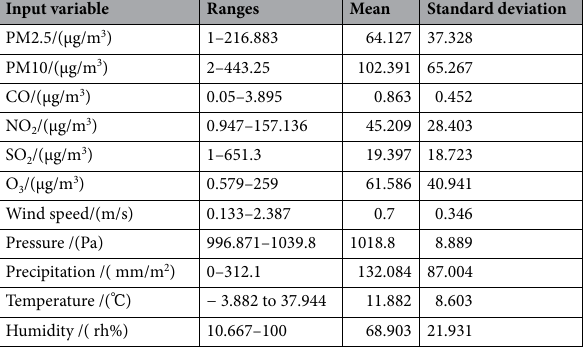
Table 1. Descriptive statistics of air quality variables from data from national control points and self-built